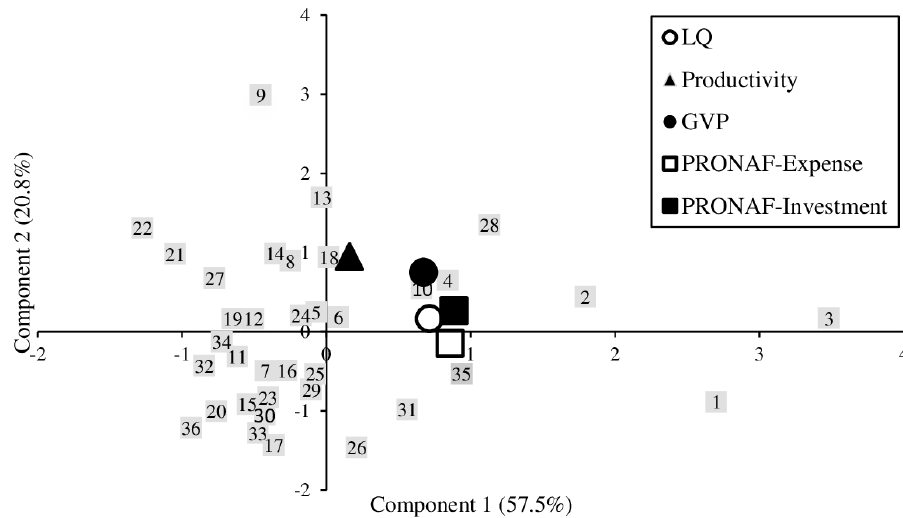
Figure 2. Principal Component Analysis (PCA) of microregions specialized in milk production in Southern Brazil. Notes: LQ: Location Quotient. GVP: Gross Value of Production. PRONAF: National Program to Strengthen Family Agriculture. 1.